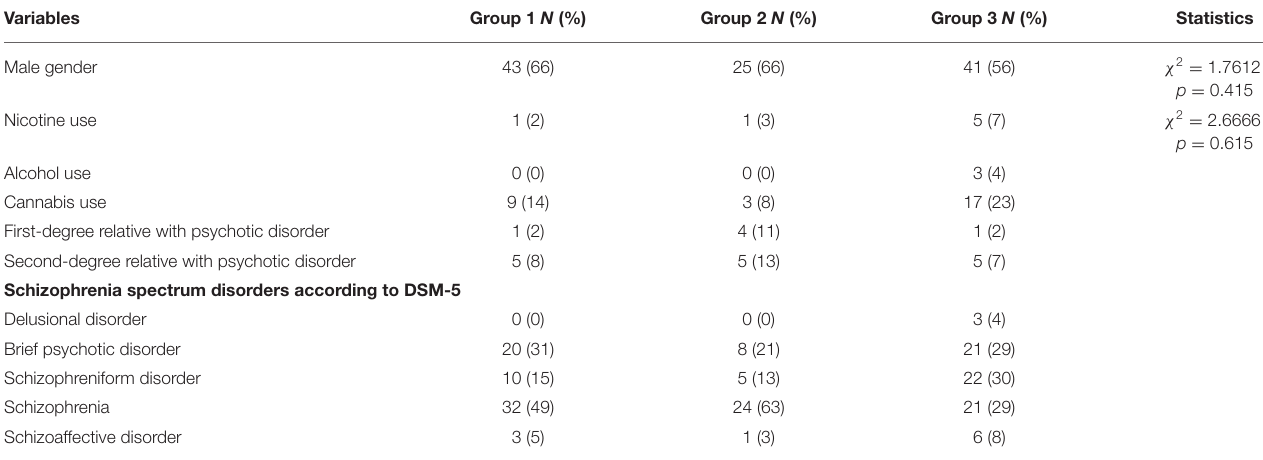
TABLE 2 | Socio-demographic and clinical data scores separately for three groups. Variables